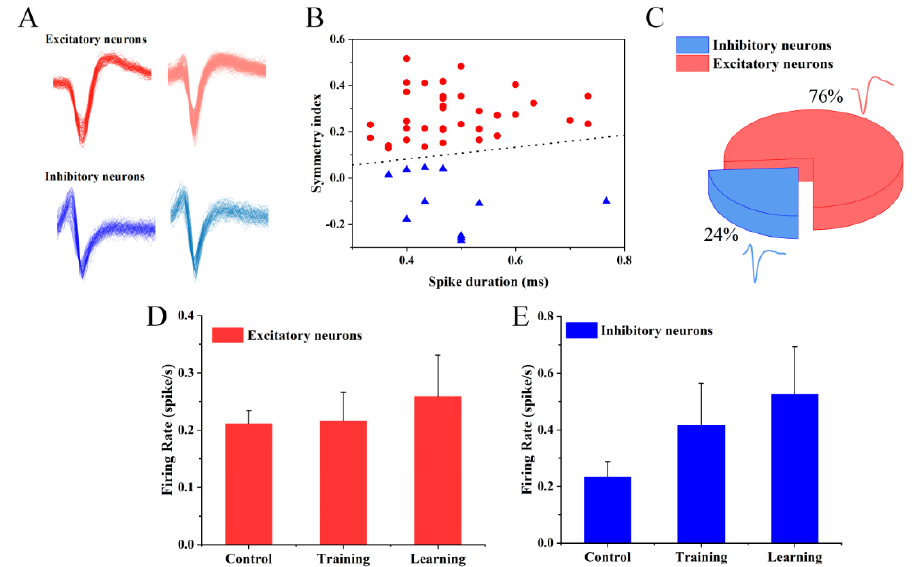
Figure 7. The cellular level changes in electrophysiology of in vitro cultured neurons through learning training. ( A ) Representative spike patterns of detected excitatory and inhibitory neurons. ( B ) The classification of neurons distinguished by the k ‐ means method. ( C ) The ratio of excitatory to inhibitory neurons. ( D ) The responses of excitatory neurons to learning and training. ( E ) The re ‐ sponses of inhibitory neurons to learning and training.